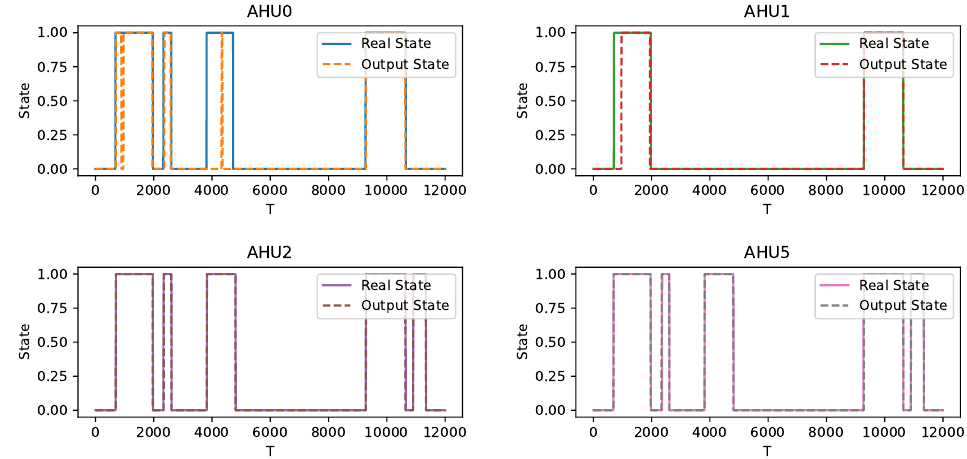
Figure 6. Comparison of the output state and the real state in the seen scenario.